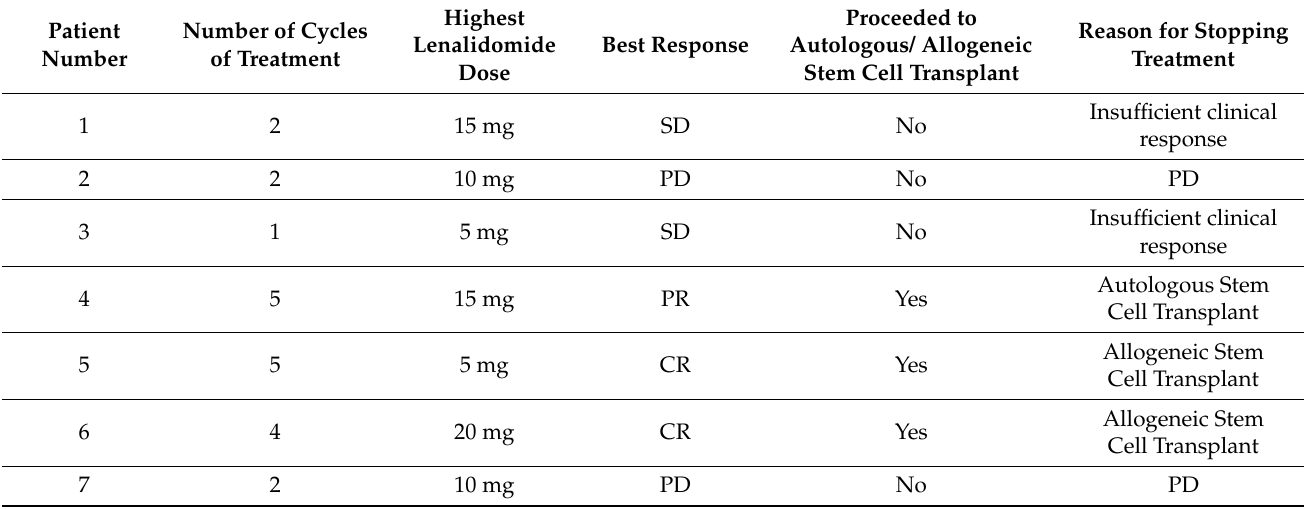
Table 3. Disposition of Patients.